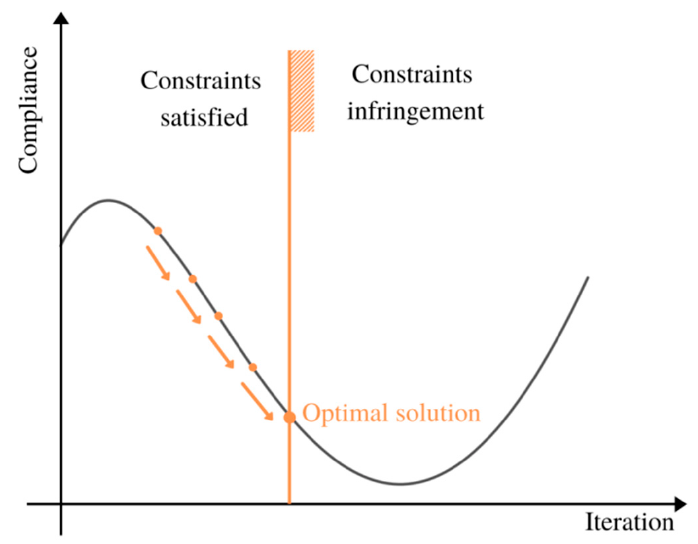
Figure 2. single constraints model example of OCM. Figure 2. Single constraints model example of